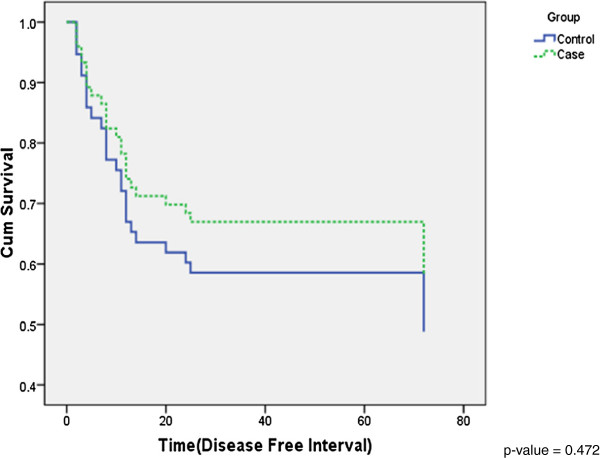
Disease free interval curves for the two groups (Cases vs. Controls).